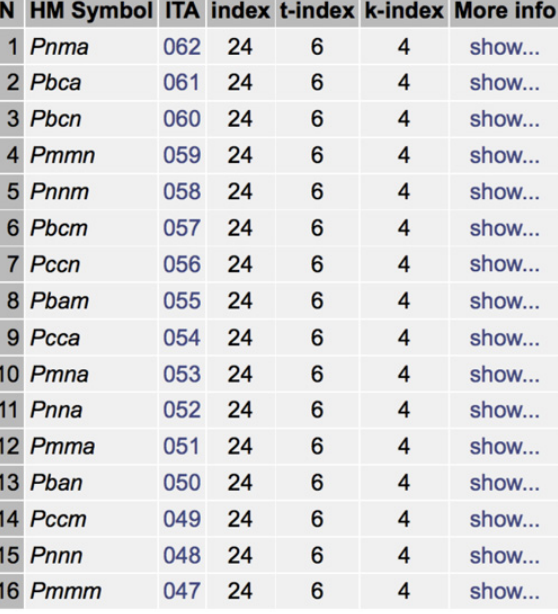
relations a and b ≈ a c